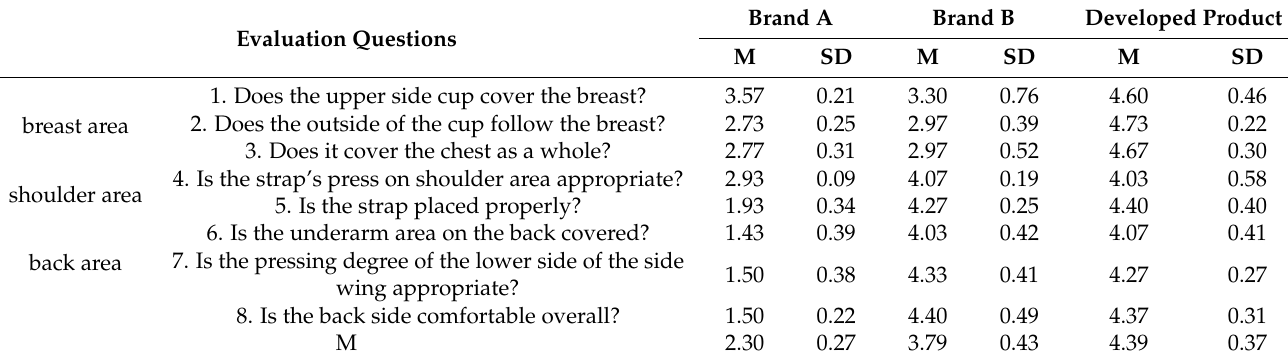
Table 4. Results of the appearance evaluation by